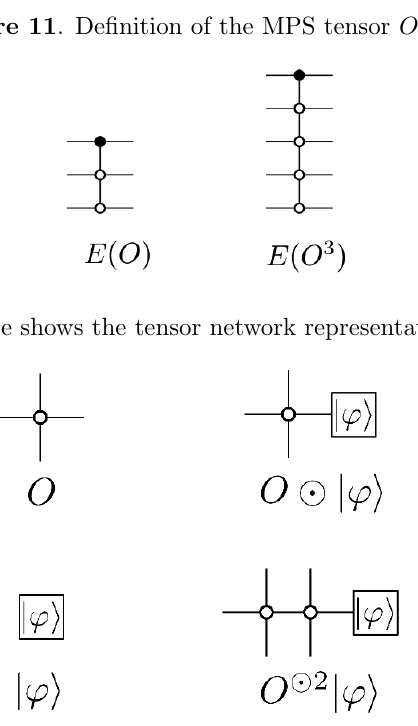
Figure 13 . This (cid:12)gure illustrates the de(cid:12)nition of the product O (cid:12) j ’ i